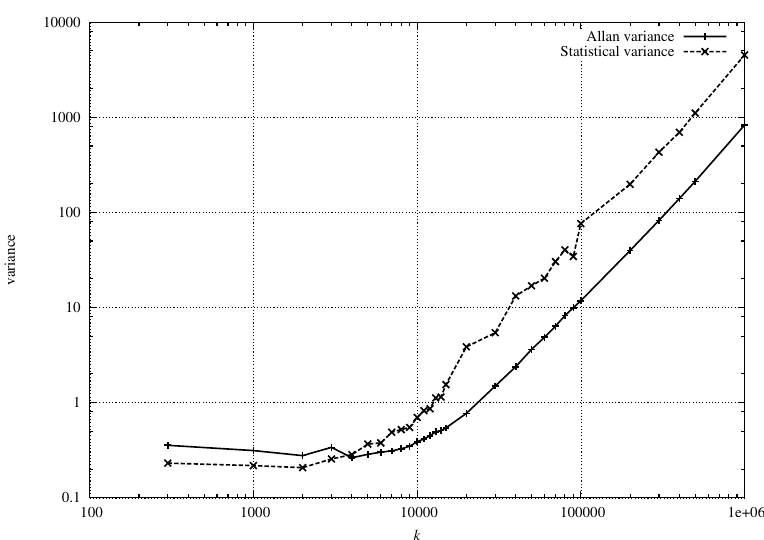
Figure 8: Variance and Allan variance of counter values depending on the measurement interval k , with two STRs as sources of the jittery clock signals